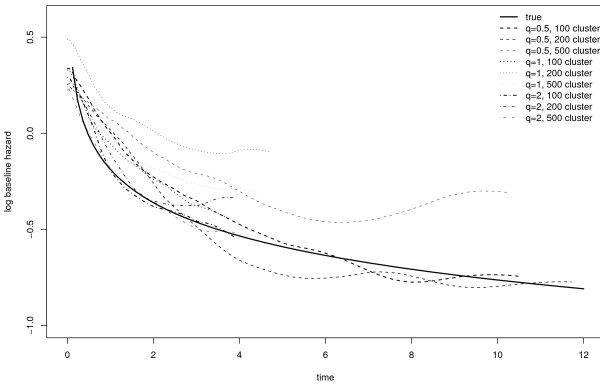
Estimated and true log baseline hazards.